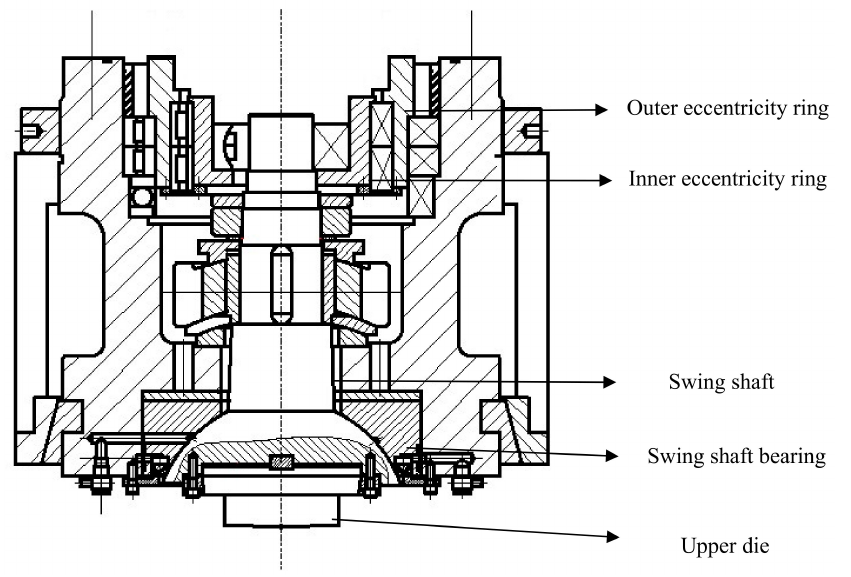
Figure 11. Structures of the critical components of the 6300 KN COF machine.